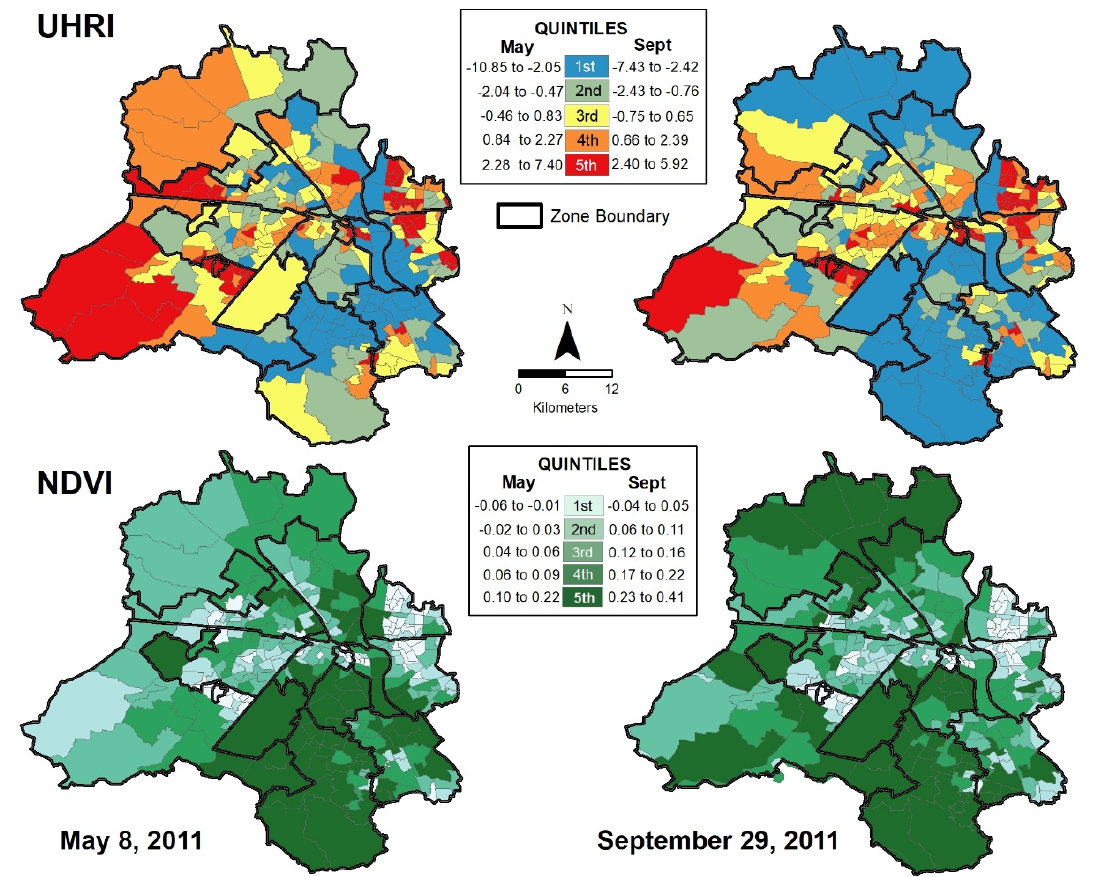
Figure 2. Ward level distribution of dependent variables for the NCT of Delhi. Top maps depict urban heat risk index and bottom maps depict NDVI, for May 8 and September 29, 2011 (Note: UHRI and NDVI calculated by author utilizing Landsat 5 TM imagery).